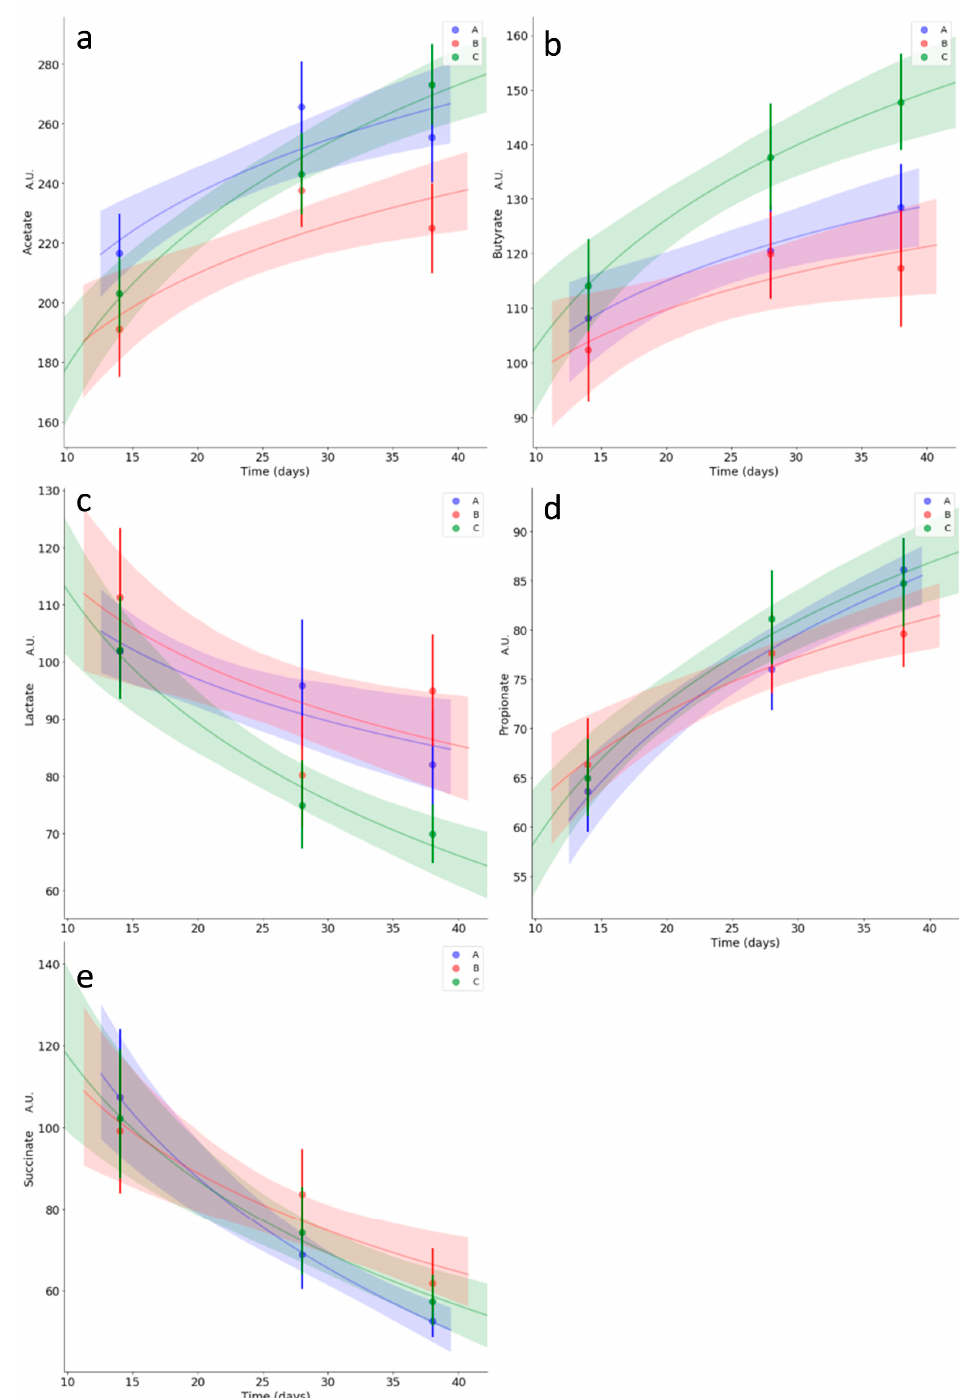
Figure 7. Kinetics for caecal concentration of acetate ( a ), butyrate ( b ), lactate ( c ), propionate ( d ) and succinate ( e ). Average values for treatment groups A, B and C are reported in blue, red and green, respectively. Translucent bands represent each fit’s 95% confidence interval. Zones of the fits with non-overlapping bands correspond to statistically meaningful di ff erences in trends between groups. Significant di ff erences in trend are seen for acetate, butyrate and lactate. Metabolites are reported using normalized signal arbitrary units (A.U.), proportional to